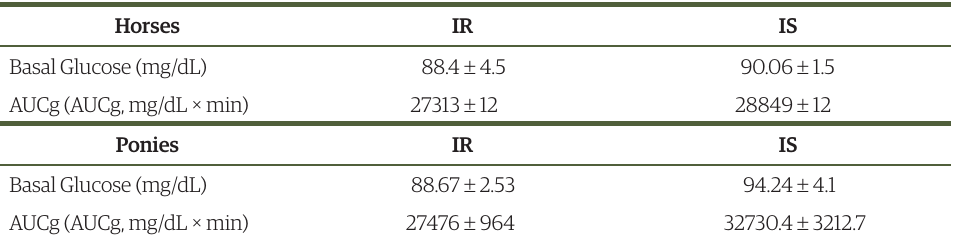
Table 3. Values basal glucose and area under the glucose curve for insulin resistant versus insulin sensitive horses and ponies.